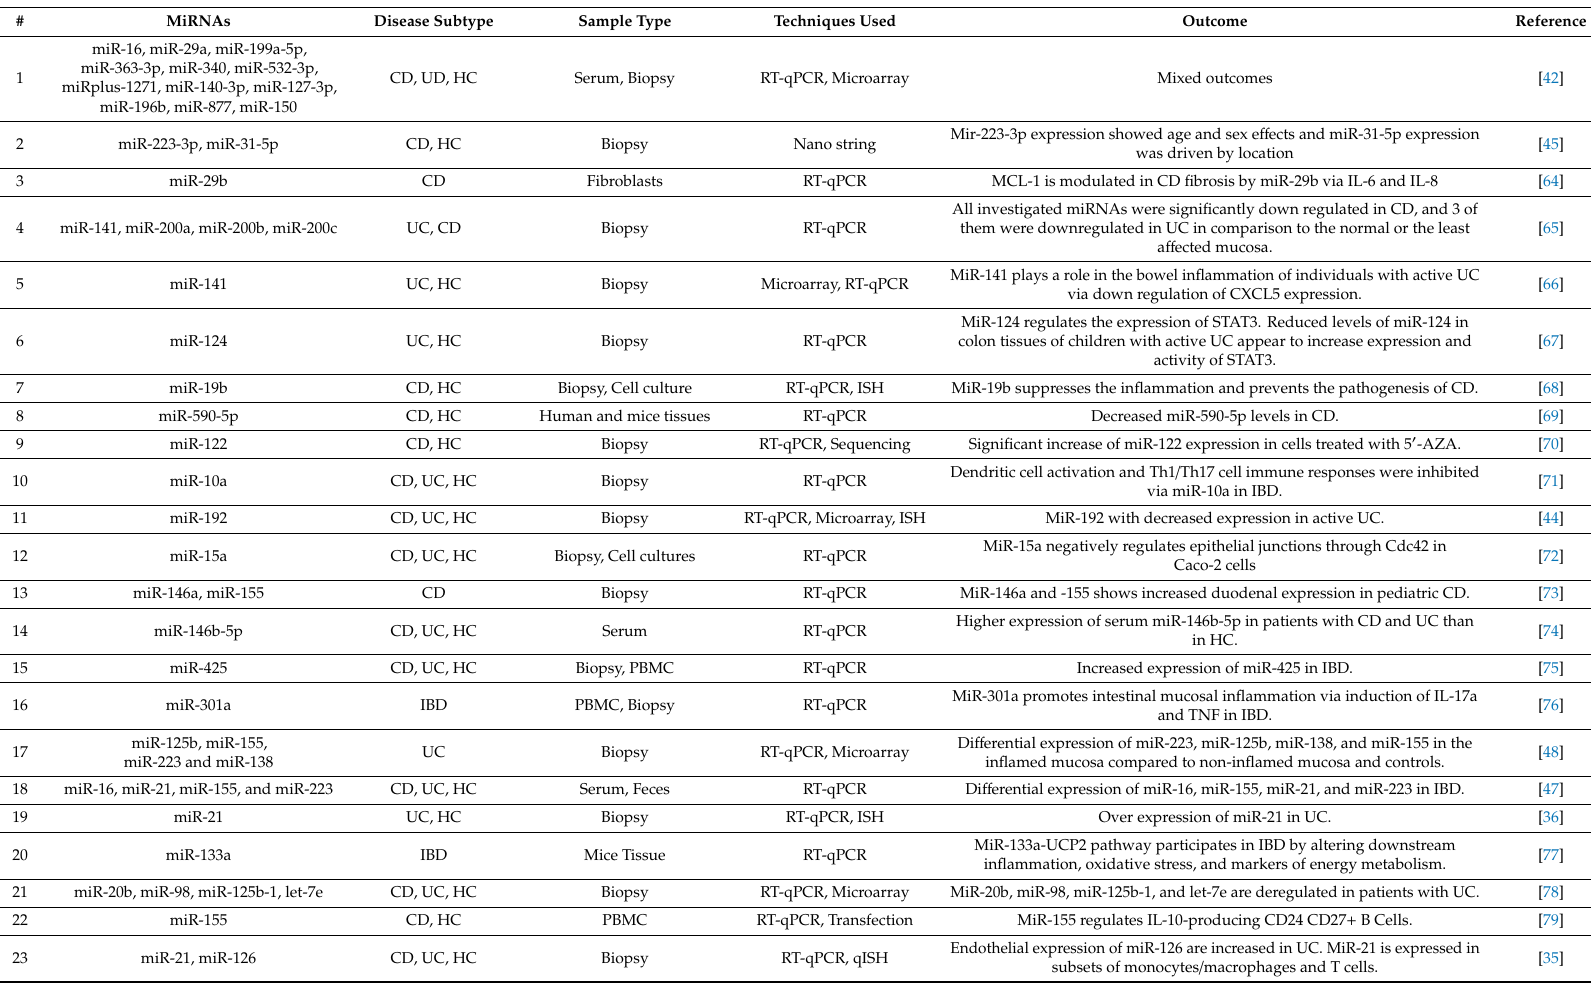
Table 1. A summary of studies on microRNA research in inflammatory bowel disease (IBD). CD: Crohn’s disease, UC: Ulcerative colitis, HC: Healthy controls, RT-qPCR: Quantitative real time polymerase chain reaction, Biopsy: colon tissue biopsy, ISH: In situ hybridization, QISH: Quantitative in-situ hybridization, PBMC: Peripheral blood mononuclear cells, DSS: Dextran sodium sulphate, AOM: Azoxymethane, TNF: Tumor necrosis factor